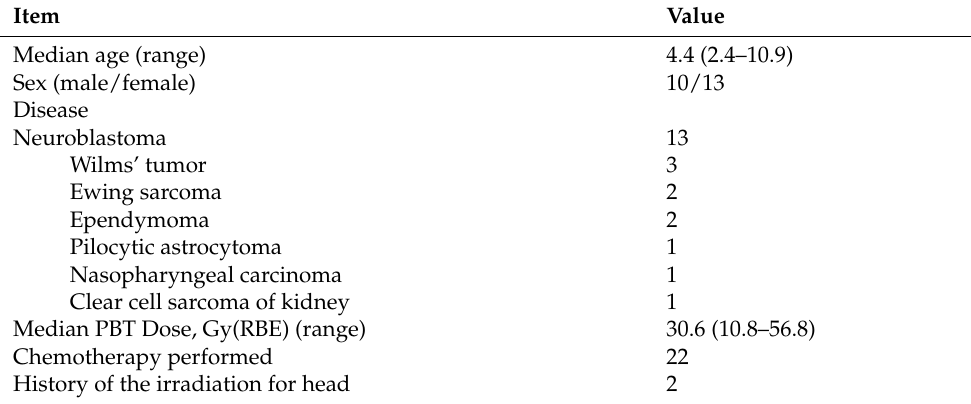
Table 2. Characteristics of patients and